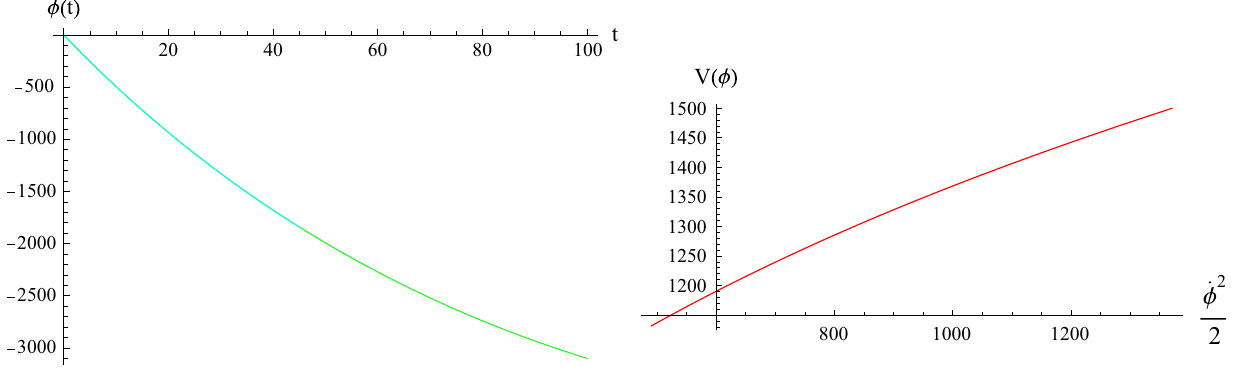
˙ φ 2 ( right ) for c 2 = 5 . 5, c 4 = − 10 3 , 2